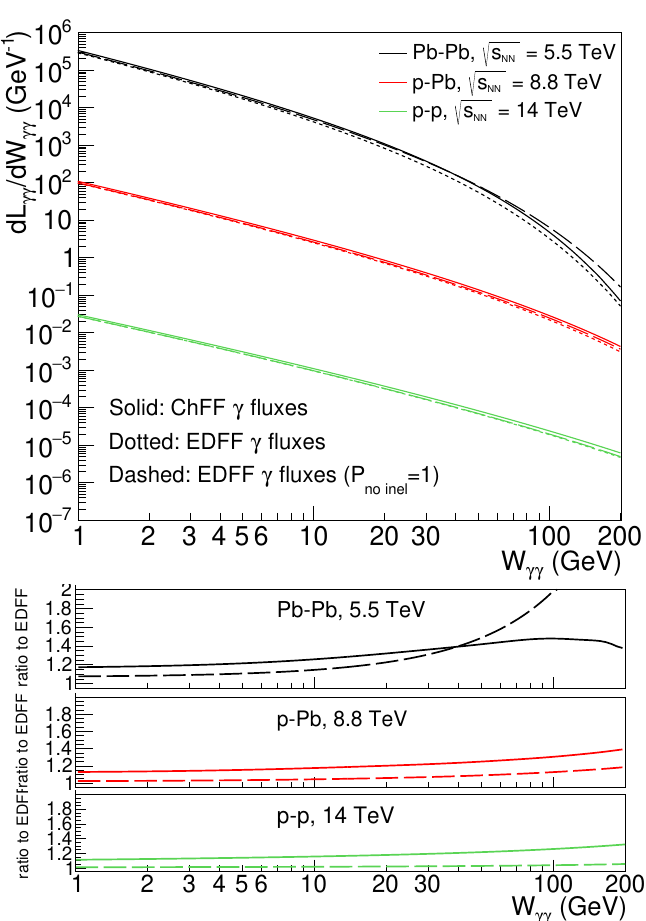
Figure 4 . Comparison of the e (cid:11) ective photon-photon luminosities d L (cid:13)(cid:13) = d W (cid:13)(cid:13) as a function of W (cid:13)(cid:13) , eq. (2.6), for ultraperipheral Pb-Pb, p-Pb, and p-p collisions at the LHC. The solid curves are obtained using ChFF, the dotted curves using EDFF, and the dashed curves using EDFF fluxes with P noinel = 1. The lower insets show the corresponding ratios over the EDFF-based